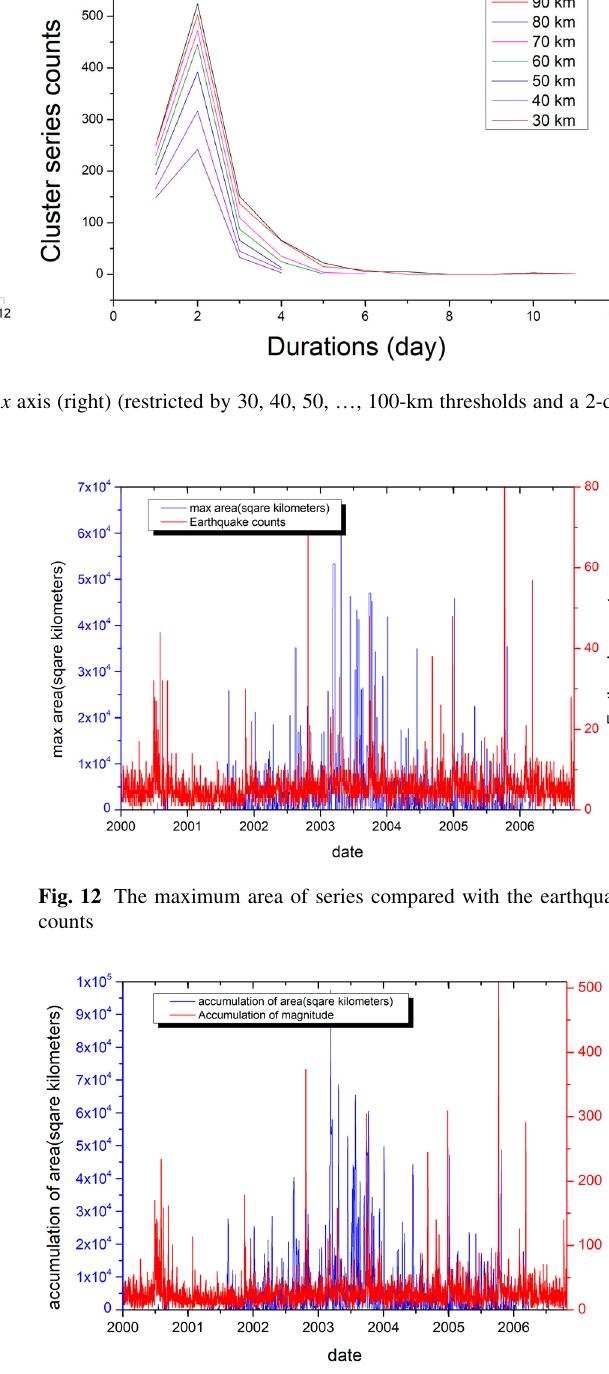
Fig. 13 The accumulation of series area compared with the accu- mulation of earthquake